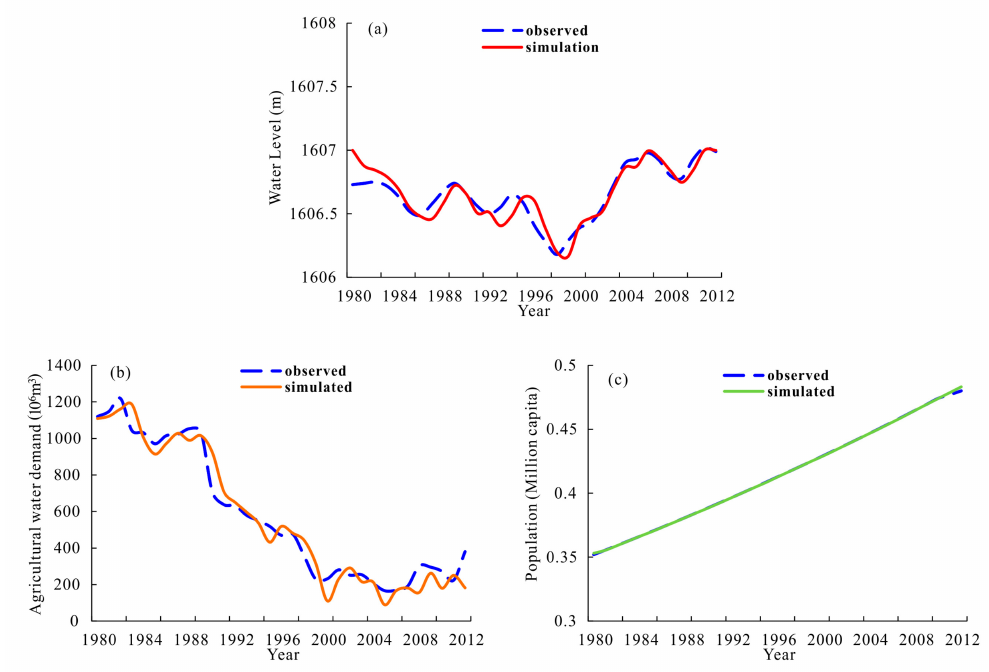
Figure 6. The comparison of observed data and simulation results. ( a ) The annual water level of Lake Issyk-Kul; ( b ) The agricultural water demand of Issyk-Ku basin; ( c ) The total population in the Issyk-Kul Oblast.